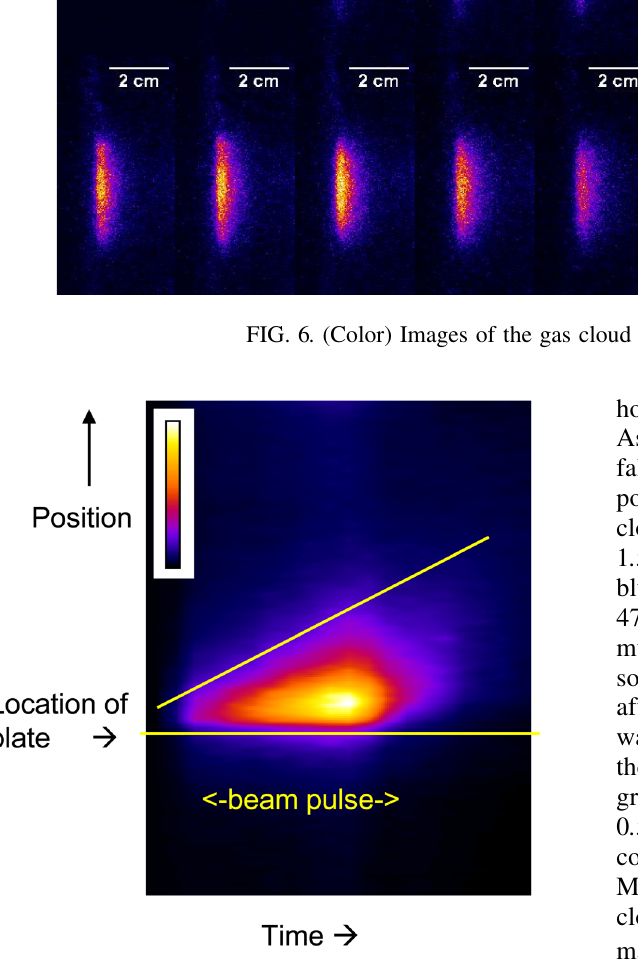
FIG. 7. (Color) Line integral of the images of Fig. 4. The sloped line indicates an expansion rate of 1 : 5 mm =(cid:1) s . The beam pulse is 4 (cid:1) s long.